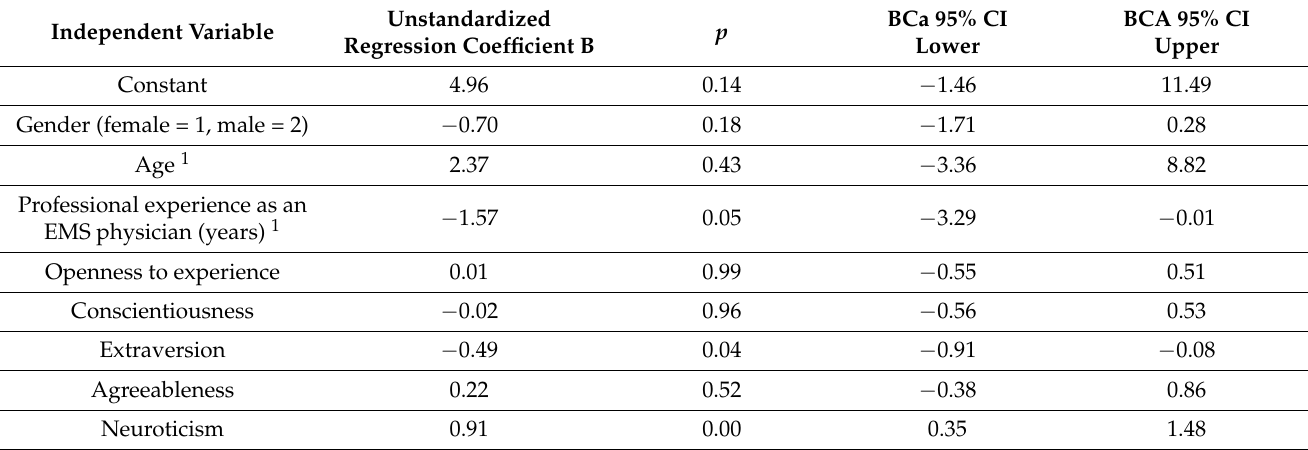
Table 4. Factors with impact on symptom load. Results of multiple linear regression.